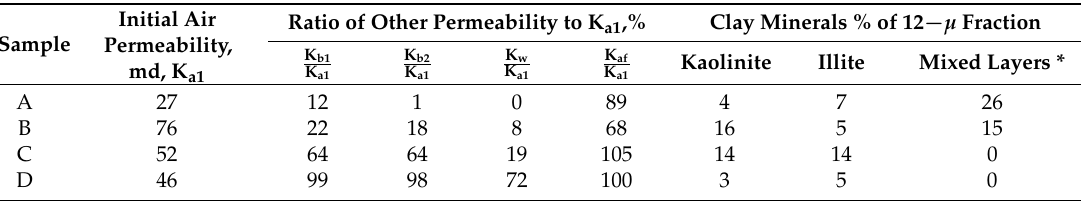
Table 2. Permeability analyses of four samples of frontier sands [47].